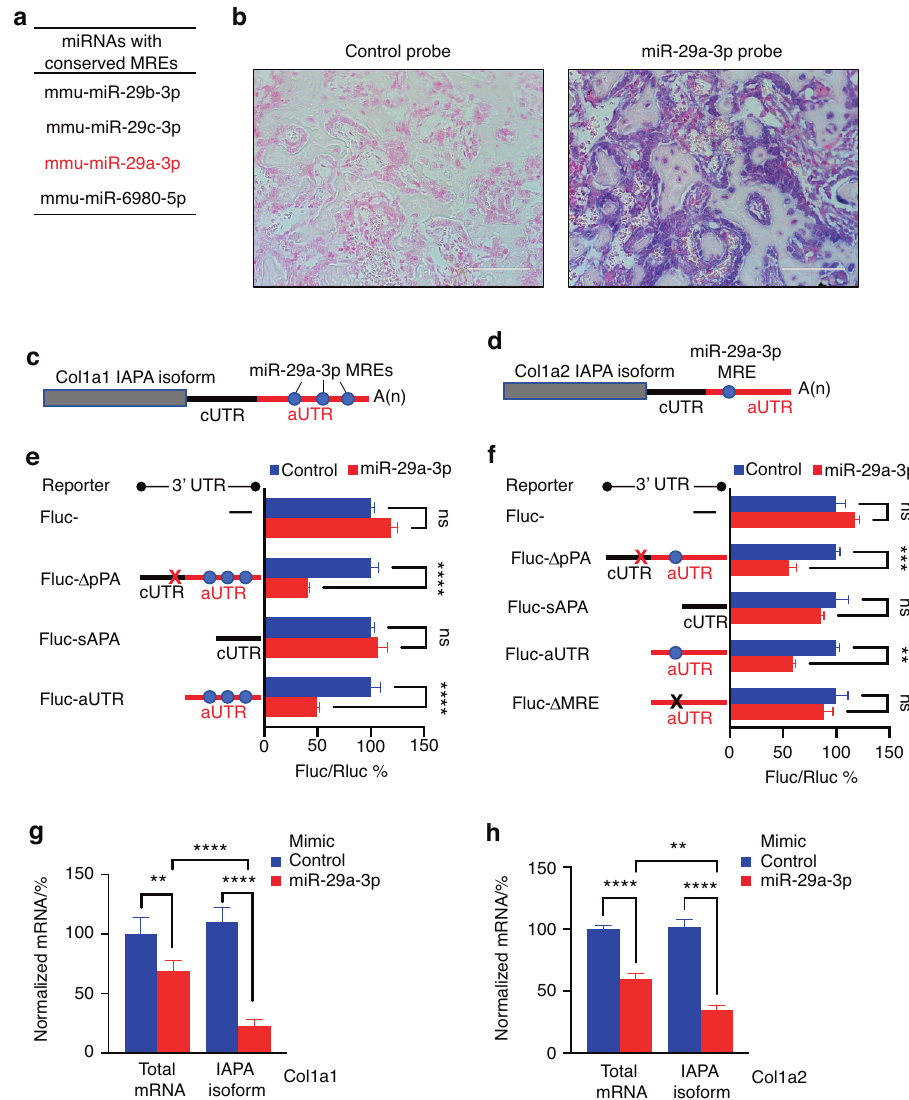
Fig. 5 miR-29a-3p mediates the degradation of the lAPA, but not sAPA, isoforms of Col1a1 and Col1a2 mRNAs. a List of miRNAs that have conserved MREs in the 3 ′ UTR of mouse Col1a1 mRNA (identi fi ed by both TargetScan and miRDB) (Tables S8 and S9). miR-29a-3p (highlighted in red) exhibited the highest expression among the 4 miRNAs in the d14 callus (Table S10). b ISH using either a control (left) or miR-29a-3p (right) probe. The results show intense staining (blue) of miR-29a-3p in the woven bone area of the d14 callus. c Schematic of the lAPA isoform of Col1a1 mRNA showing the putative miR-29a-3p MREs in the aUTR. d As in c except Col1a2 mRNA is shown. e Bar graph of the results of dual luciferase assays that were performed in MC3T3 cells transfected with the indicated Col1a1 FLuc reporters along with either a control (blue) or miR-29a-3p (red) mimic. FLuc activity was normalized to RLuc activity, and the FLuc/RLuc ratio in cells transfected with the control mimic was de fi ned as 100. n = 4 – 5 independent transfections, each measured in triplicate. f As in e except the cells were transfected with Col1a2 FLuc reporters. In the FLuc- Δ MRE reporter, we replaced the binding region of the miR-29a-3p seed sequence with a random sequence (denoted by “ X ” ). g RT ‒ qPCR quanti fi cation of the expression of either total mRNA or the lAPA isoform of Col1a1 in MC3T3 cells transfected with control (blue) or miR-29a-3p (red) mimic. Primers that bind within the aUTR region were used to speci fi cally amplify and quantify the levels of lAPA isoform (Table S14). The expression level was normalized to that of β -actin mRNA, and the normalized level in control mimic-transfected cells was de fi ned as 100. n = 5. h As in g except that the expression levels of total mRNA and the lAPA isoform of Col1a2 were quanti fi ed. The bar graphs present the average ± SEM. (ns) P > 0.05; ** P < 0.01; *** P < 0.001; **** P < 0.000 1. The signi fi cance of the difference was calculated using unpaired Student ’ s t test in e and f and two-way ANOVA in g and Shortening of the Irak2 3 ′ UTR was accompanied by a signi fi cant (Figs. 7b and S14b). These results highlight the impact of 3 ′ UTR increase in gene expression, as demonstrated by RNA-seq data shortening on enhancing gene expression during endochondral (Table S1) and RT ‒ qPCR analysis (Fig. 7d), and this result was ossi fi cation. consistent with the global trend. 3 ′ RACE experiments con fi rmed Interleukin-1 receptor-associated kinase 2 (Irak2), a serine/ the expression of 2 main APA isoforms of Irak2 in the callus threonine kinase that associates with the interleukin-1 receptor (Fig. 7e), mapped the 3 ′ end of each isoform (Fig. S14c), and upon activation, is one of the genes that was identi fi ed by InPAS con fi rmed the shortening of the Irak2 3 ′ UTR on d21 relative to and APAlyzer to undergo signi fi cant 3 ′ UTR shortening during d14 (Fig. 7e). We then investigated whether the ratio of Irak2 APA endochondral ossi fi cation (Fig. 7c and Tables S4 and S5).